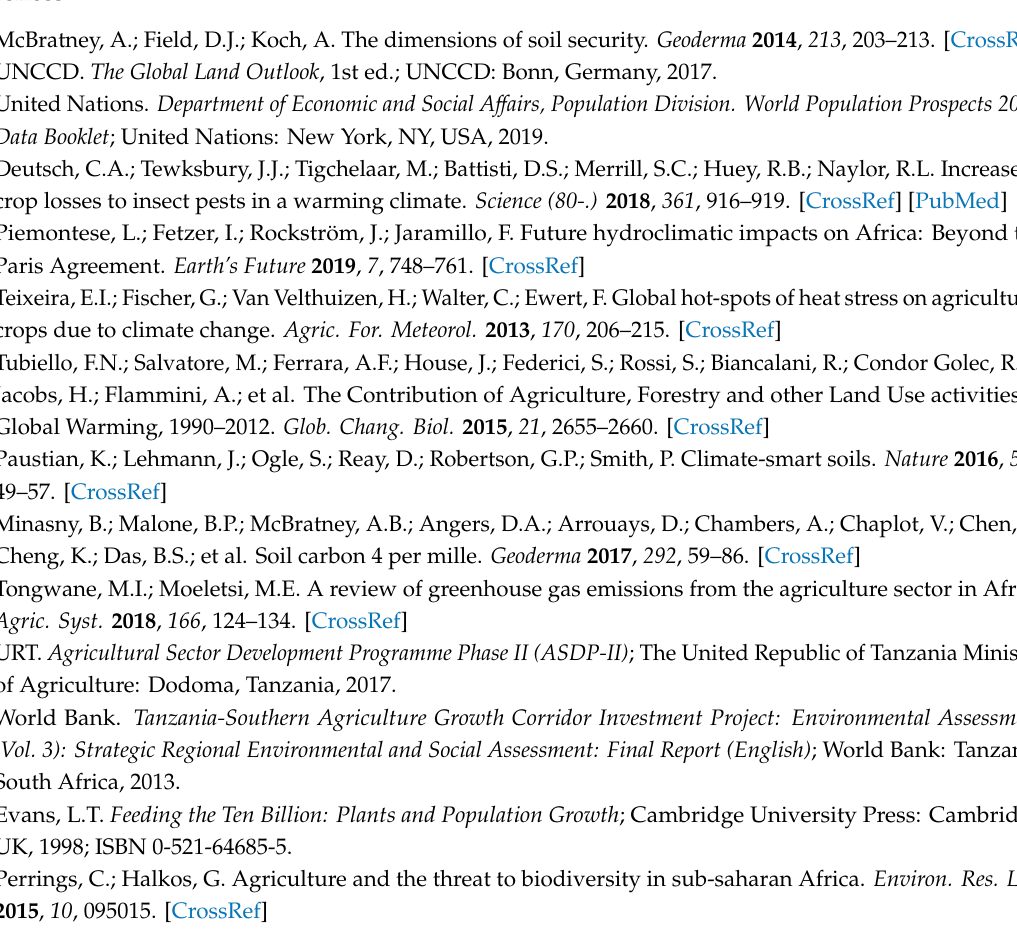
Figure S1: Soil texture ternary plot for each soil layer, for: (a) 0–20 cm; (b) 20–30; (c) 30–40 cm; (d) 40–50 cm; (e) 50–60 cm; (f) 60–80 cm. Points consisting of an outer ring of a di ff erent color to its center represent points with identical results between two LMPs. Table S1: Dummy variable values. A 1 denotes the presences of a specific property, Data S1; the original data file containing all sampling